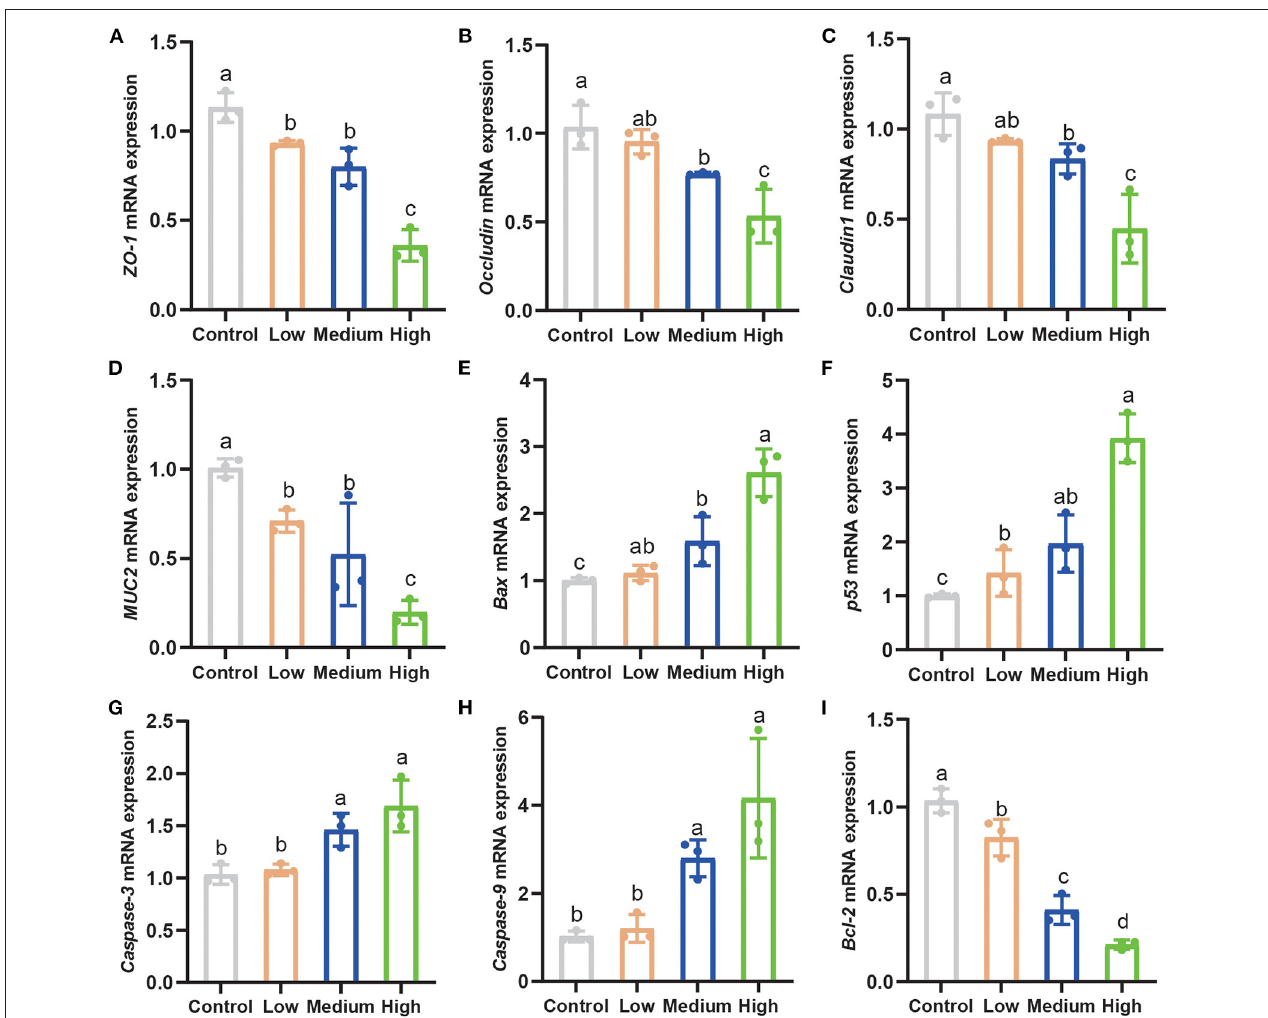
FIGURE 7 | Clostridium perfringens facilitated apoptosis and weakened tight junctions related genes expression. (A–C) The tight junctions related genes expression in the jejunum of mice. (D–I) The apoptosis-related gene expression in the jejunum. Results are presented as mean ± SD. a , b , c , d Means values with dissimilar letters were significantly different ( P <